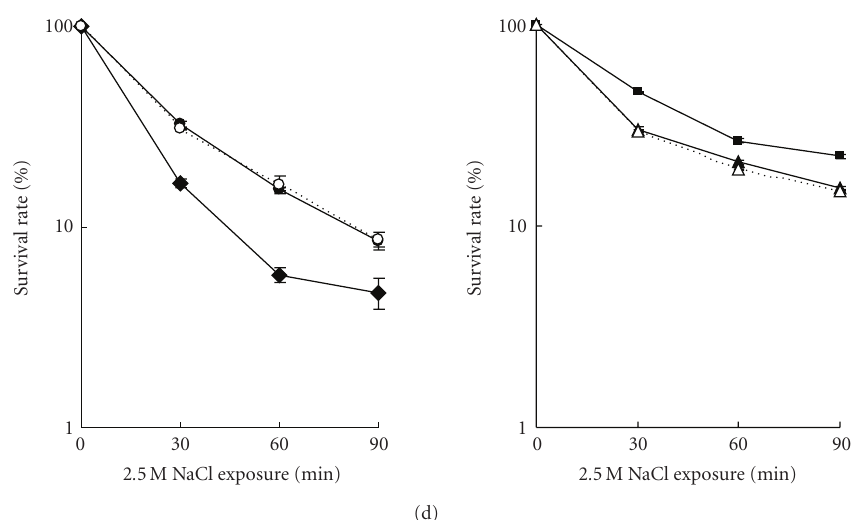
Figure 6: Stress survival of stationary-phase V. alginolyticus cells. Wild type (Op: closed circle; Tr: closed triangle), rpoX null mutant (Op: closed diamond; Tr: closed square), and complemented strains (Op: open circle; Tr: open triangle) were exposed to various stress conditions and the survival rate was determined as percentage of viable cells at the indicated time points. One hundred percent survival corresponds to number of viable cells prior to exposure to the indicated stress: (a) 45 ◦ C heat shock, (b) 30mMH 2 O 2 , (c) 18% ethanol (d) and 2.5